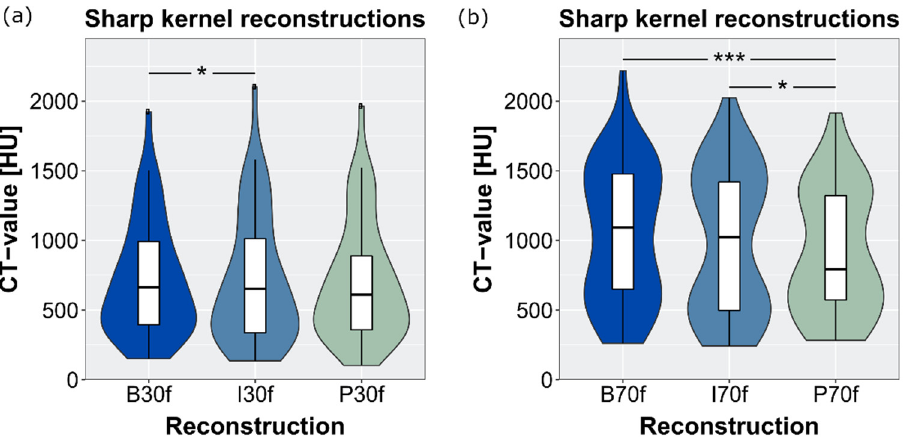
Figure 2. CT values measured from stones in ( a ) soft kernel reconstructions (filtered back-projection